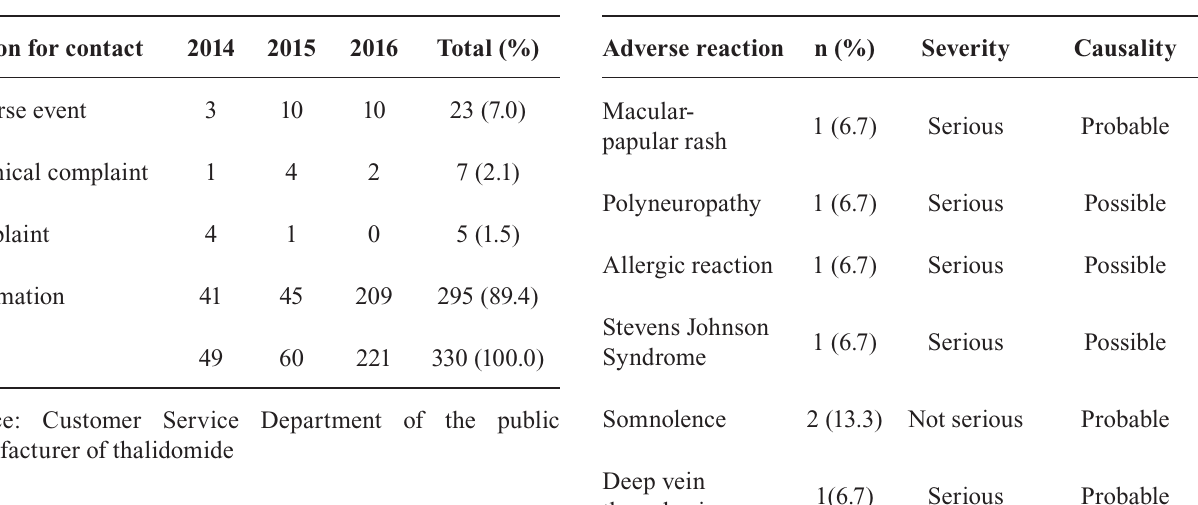
TABLE III - Notification of adverse events related to the use of thalidomide (n =